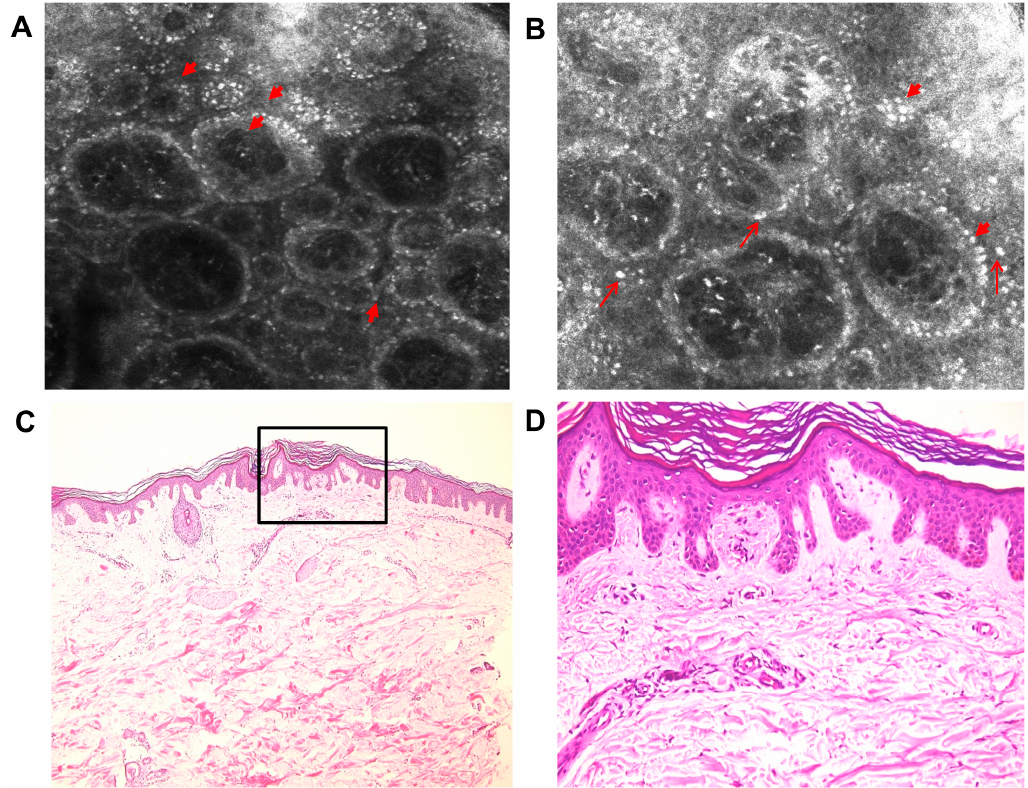
Figure 3. Correlation between RCM and histological images. RCM images at the dermal–epidermal junction level ( A ) (0.5 × 0.5 mm) and ( B ) (0.4 × 0.4 mm) showing highly refractile basal cells due to increased melanin (short red arrows) and bright plump, oval to stellate-shaped cells (thin red arrows). Histopathological images ( C ) (HE, × 4) and ( D ) (HE, × 20) showing increased melanin deposition in the basal layer and scant inflammatory reaction in the superficial dermis.